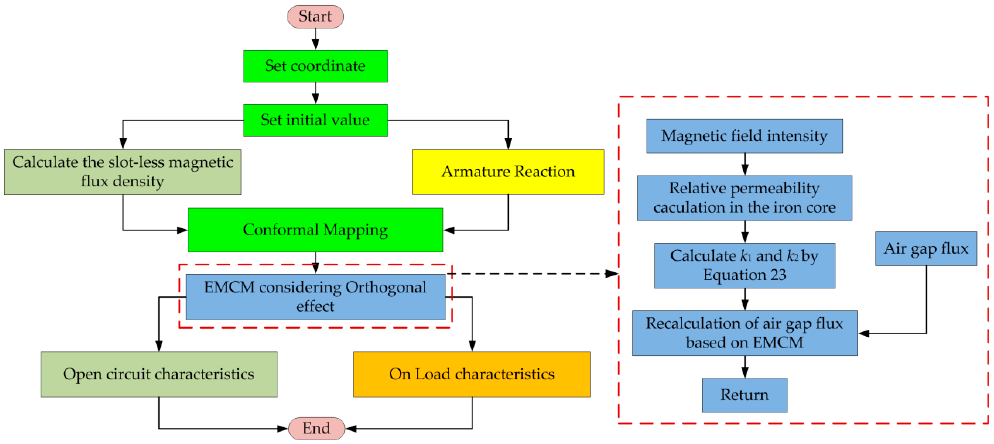
Figure 9. Calculation process.